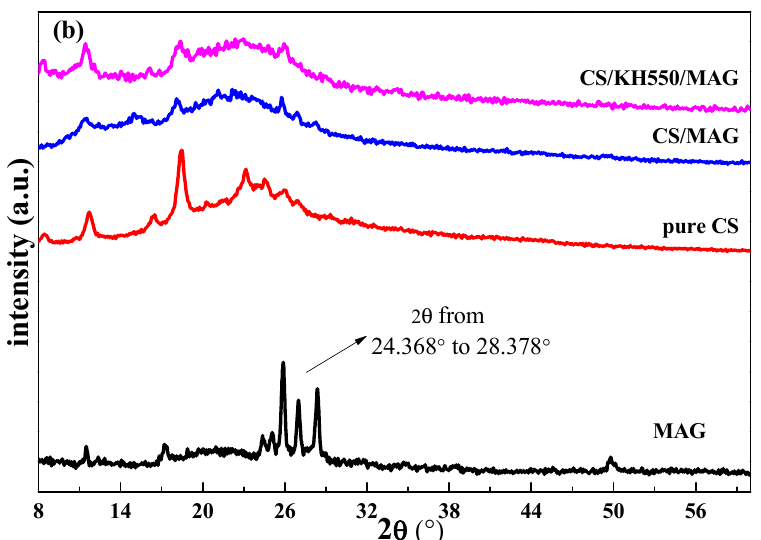
Figure 2. The ( a ) small angle and ( b ) wide-angle X-ray diffraction (XRD) patterns of CS/MAG and CS/KH550/MAG hybrid membranes.